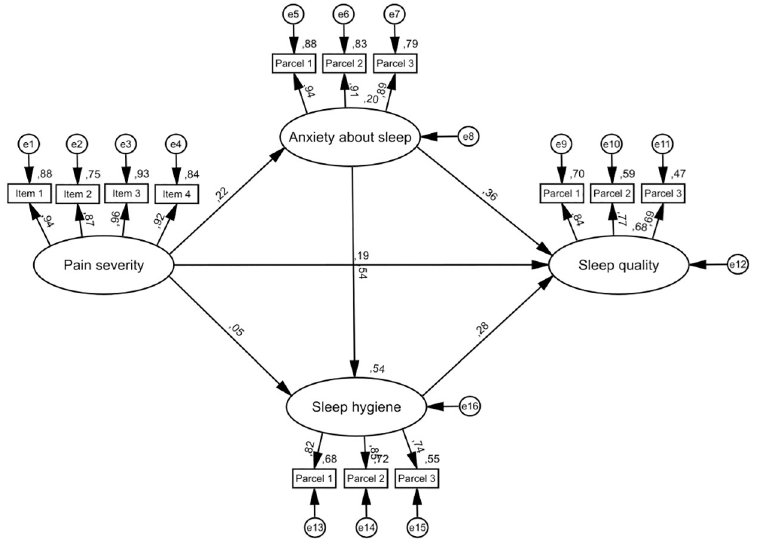
Fig 1. Model 1—Indirect paths between pain severity and sleep quality. N = 468. Rectangles represent observed variables and ovals represent latent variables. All values are standardized coefficients, except for values near variables, which are squared multiple correlations. Error terms of variables are depicted as e1-e12. Control variables (age, gender, ethnicity, employment and marital status, educational level, perceived health, taking sleep medications, taking non- sleep medications and history of sleep disorders) are not depicted to support visual clarity. For sleep quality and sleep hygiene higher scores indicate poorer sleep quality/sleep hygiene.